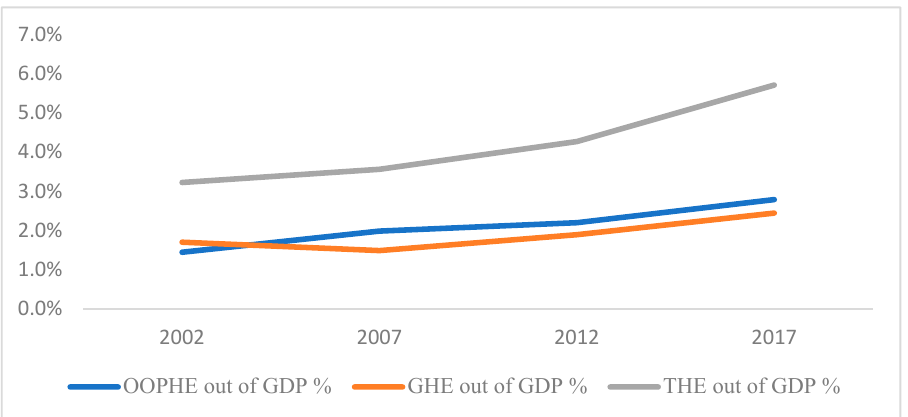
Figure 3. Change in OOPHE, GHE and THE as a percentage of GDP.